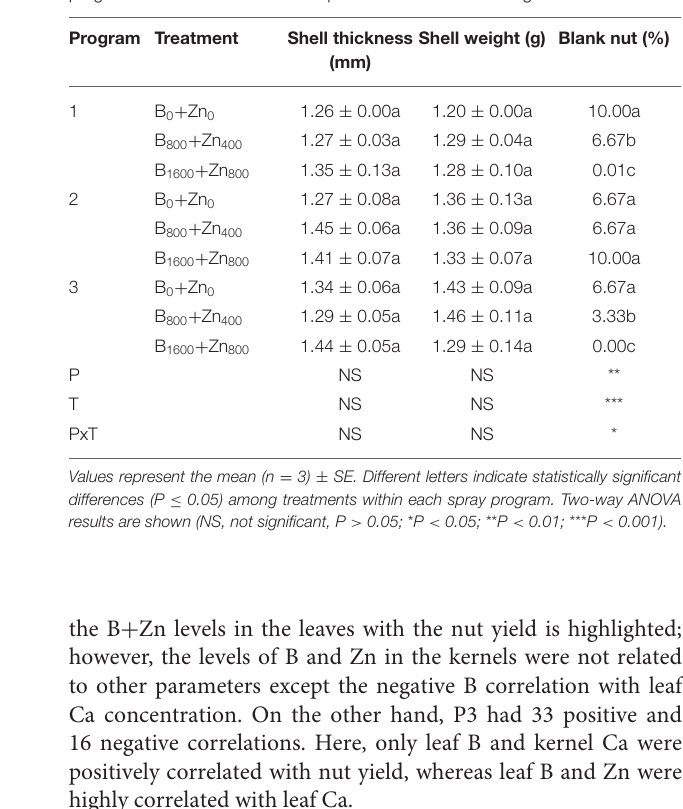
the B + Zn levels in the leaves with the nut yield is